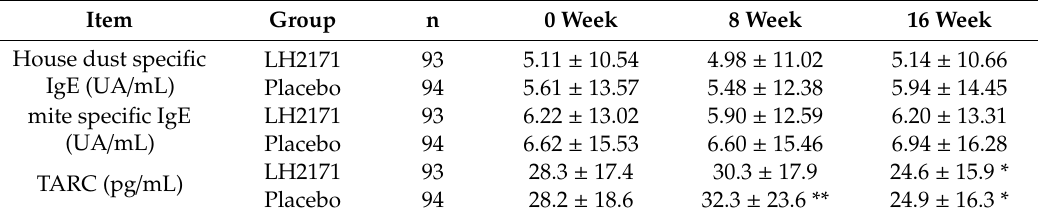
Table 6. Allergy-related blood